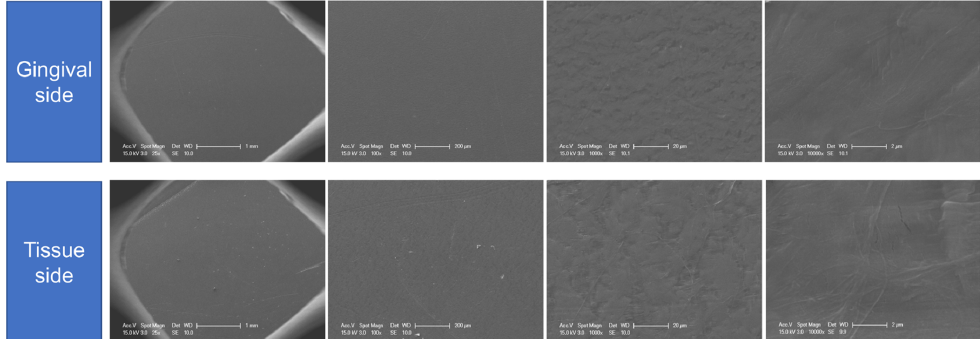
Figure 8. Scanning electron microscopy images of the gingival and bone sides of the microporous ex- panded polytetrafluoroethylene membrane evaluated in this study. Images show high-magnification views on each